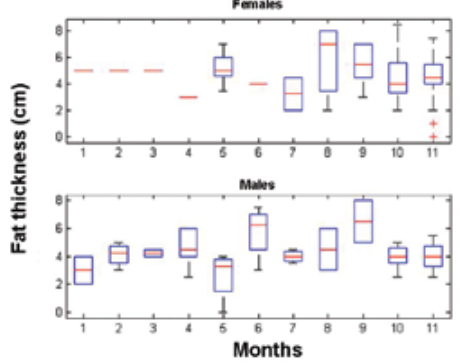
Fig. 5. Seasonal changes, by month, in condition as indicated by fat-thickness at lower end of sternum of adult (5+ years) female and male grey seals (Hali - choerus